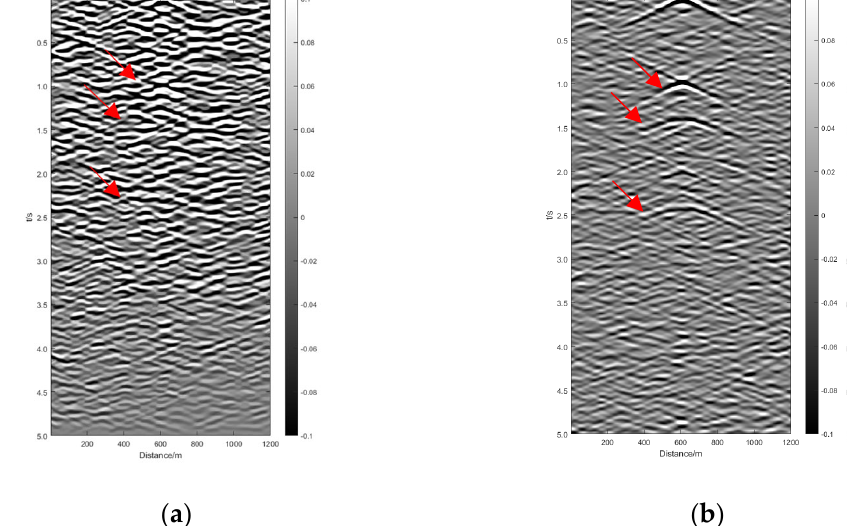
Figure 4. Reconstruction result of cross-correlation between passive seismic records with short periods and passive seismic records with long periods. ( a ) The reconstructed result of passive seismic records with short periods; ( b ) the reconstructed result of passive seismic records with long periods.